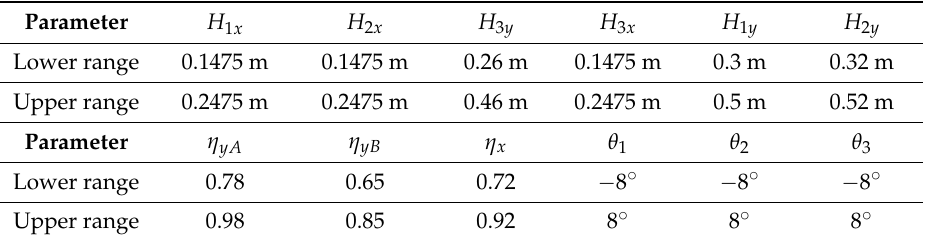
Table 3. The search ranges of the parameters using Model (15).